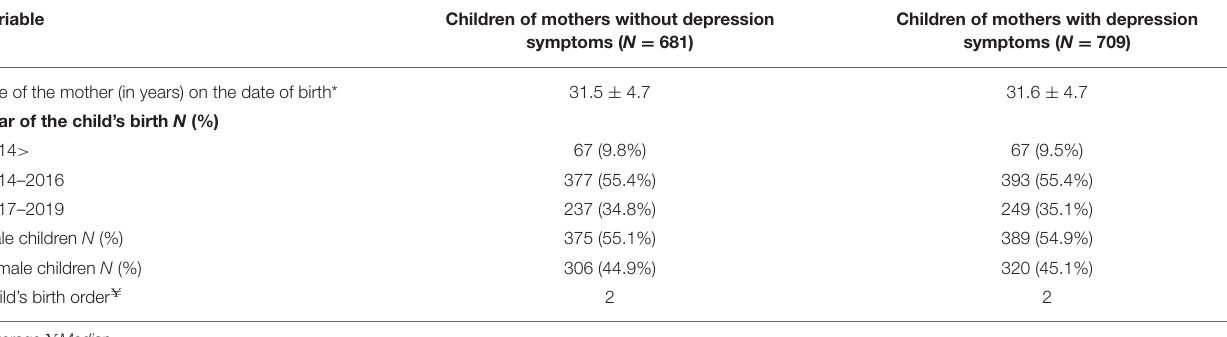
TABLE 2 | Characteristics of the group of children whose mothers had postpartum depression symptoms and who received drug treatment, and of the group of children whose mothers had postpartum depression symptoms and who did not receive drug treatment. Variable